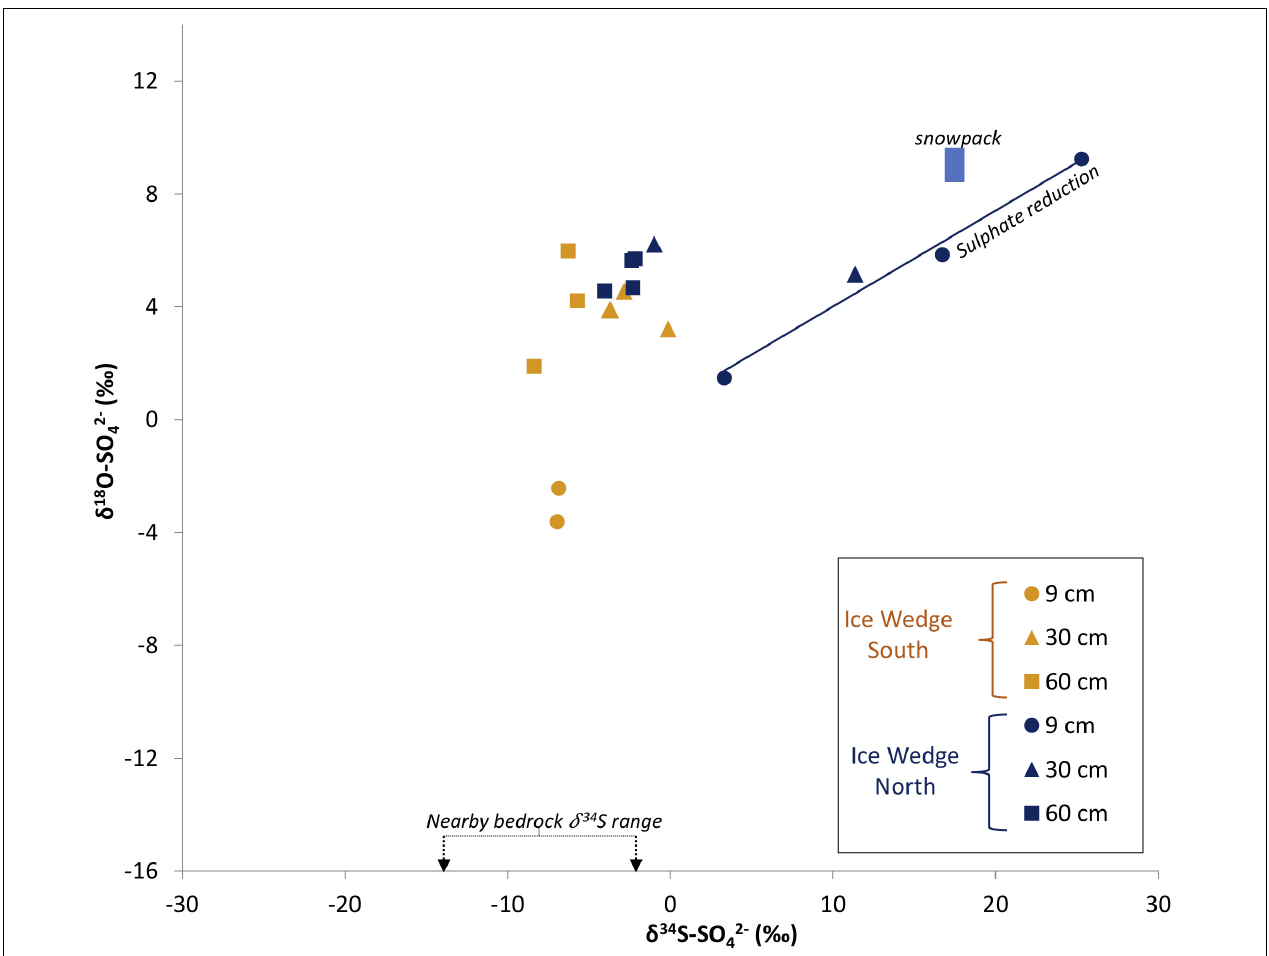
FIGURE 8 | Water samples from the active layer of Ice Wedge South and Ice Wedge North in δ 18 O-SO 4 and δ 34 S-SO 4 isotope space. The blue box represents the isotopic range of pre-melt snowpacks in Svalbard at Midtre Lovenbreen (Wynn et al., 2006) and near Ny Ålesund (Tye and Heaton, 2007). The solid blue line is a regression line illustrating reduction of sulphate by SRB (R 2 = 0.98). The nearby bedrock range is of the mass-weighted mean sulfide δ 34 S in the Firkanten and Carolinefjellet